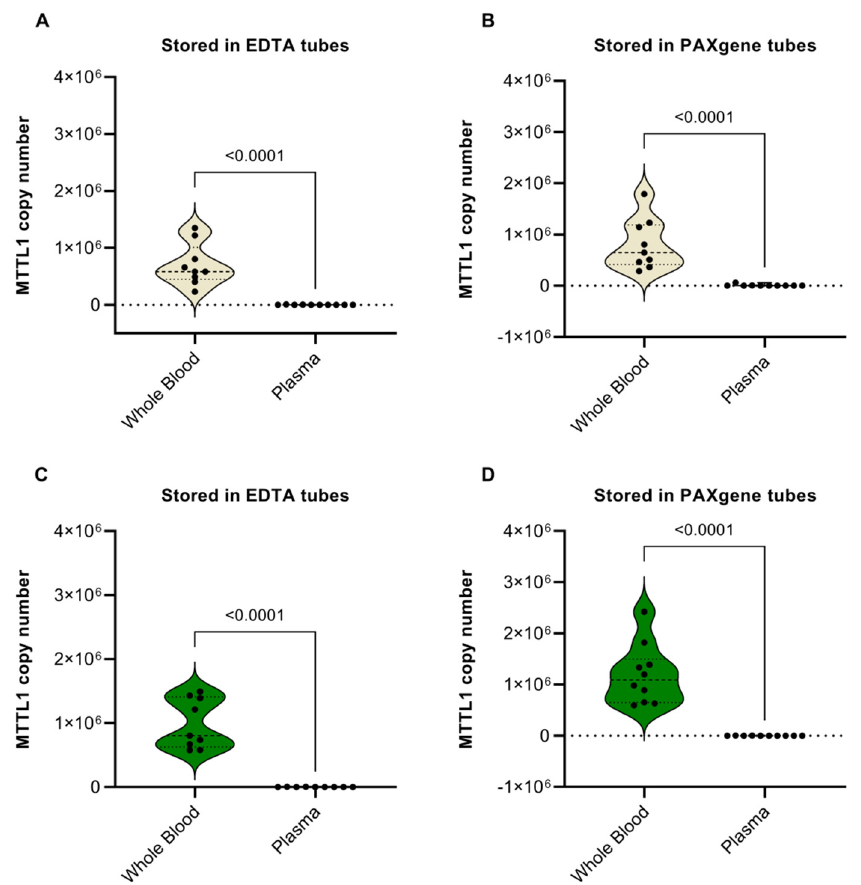
Figure 1. Mitochondrial DNA levels in whole blood vs. plasma. Violin plots showing the comparison of mitochondrial DNA (mtDNA) copy number in whole blood and plasma samples from healthy subjects stored in ( A ) EDTA and ( B ) PAXgene tubes and in pancreatic cancer patients stored in ( C ) EDTA and ( D ) PAXgene tubes. MtDNA was obtained by semi-automated isolation using the Maxwell RSC Instrument and quantified by an MT-TL1 qPCR assay. Ten subjects were recruited in each cohort. Significant outliers were identified and omitted using Grubb’s test (Alpha = 0.05). p -values < 0.05 indicate a statistically significant difference.